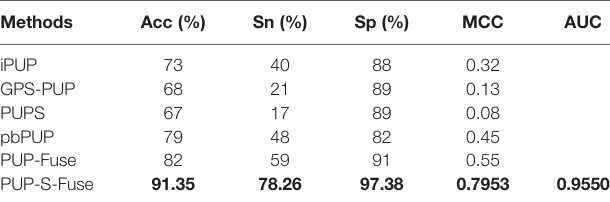
TABLE 8 | Comparison of methods on Independent Dataset for predicting pupylation